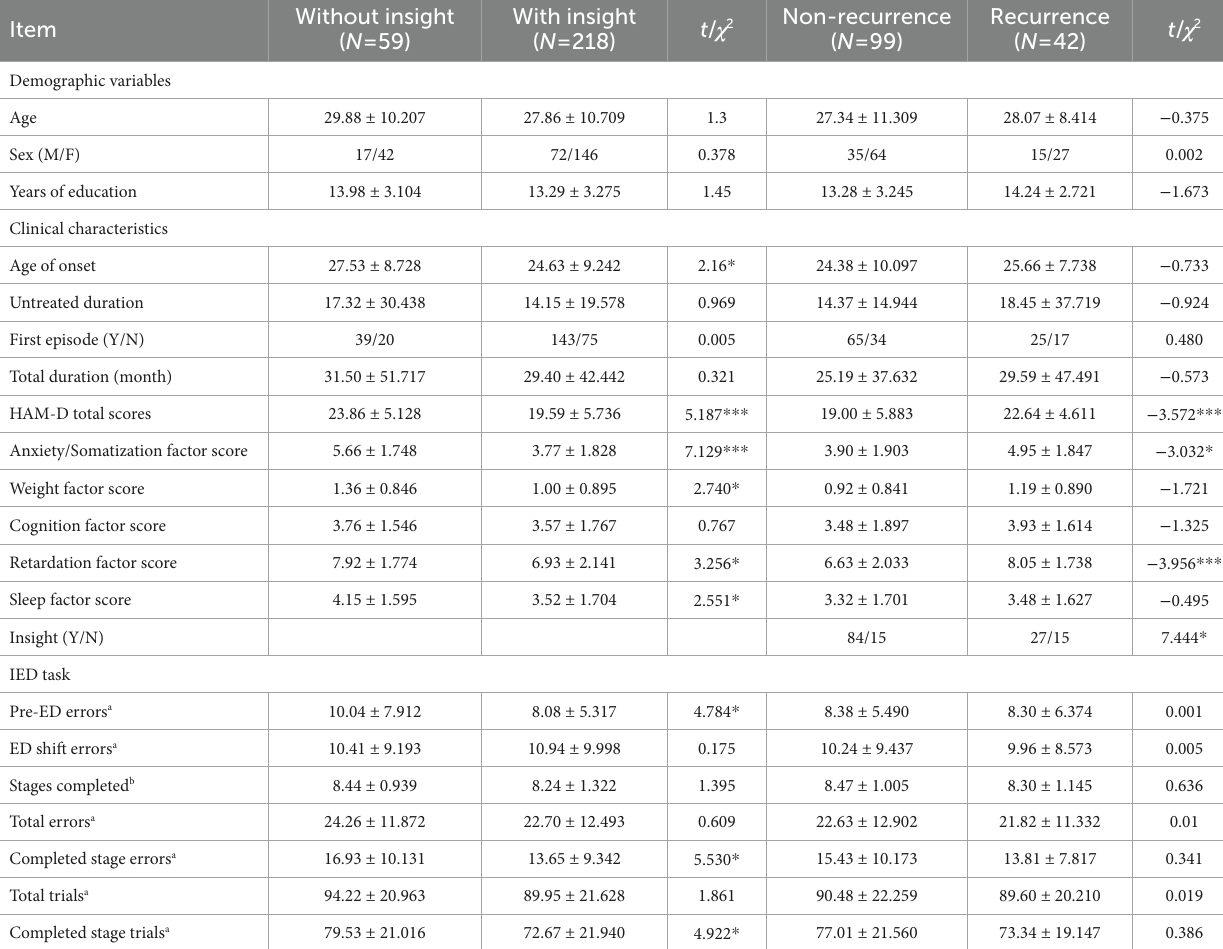
TABLE 1 Differences in demographics and clinical characteristics of patients with MDD grouped by insight and recurrence.